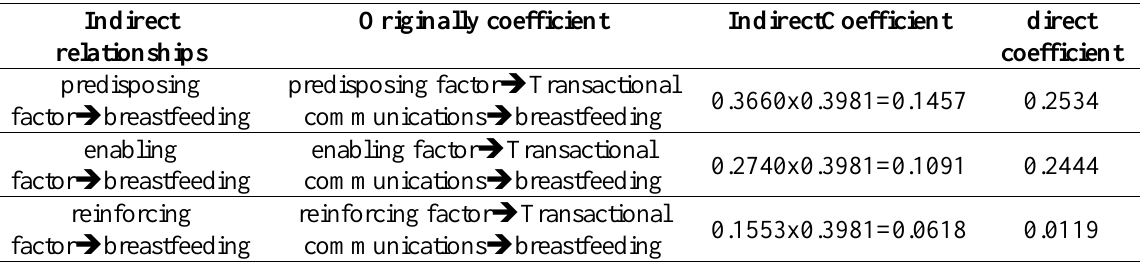
Table 6. Indirect Relation and Its Comparison to Direct